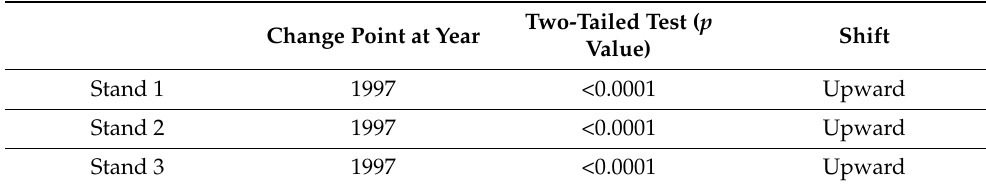
Table 5. Results of the Pettitt homogeneity test for Mean T ◦ C and the statistically significant change